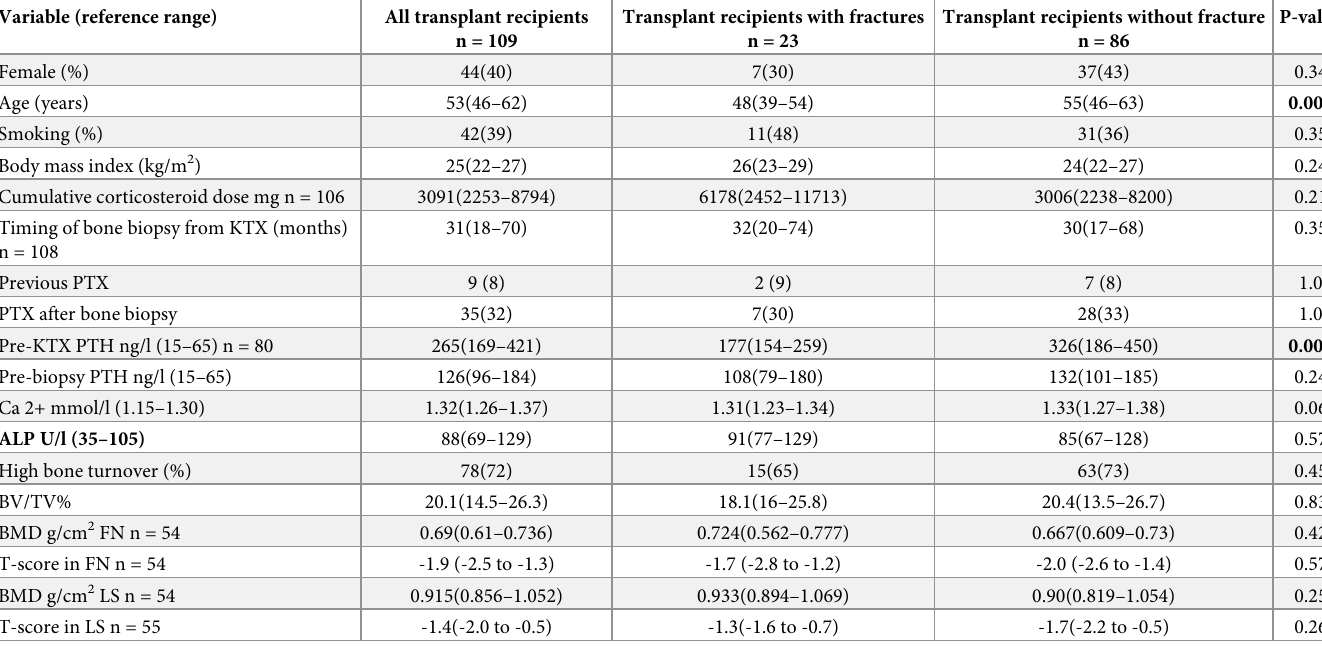
Table 3. Characteristics, biochemical parameters, bone histomorphometry and densitometry findings in transplant recipients with and without incident fractures.